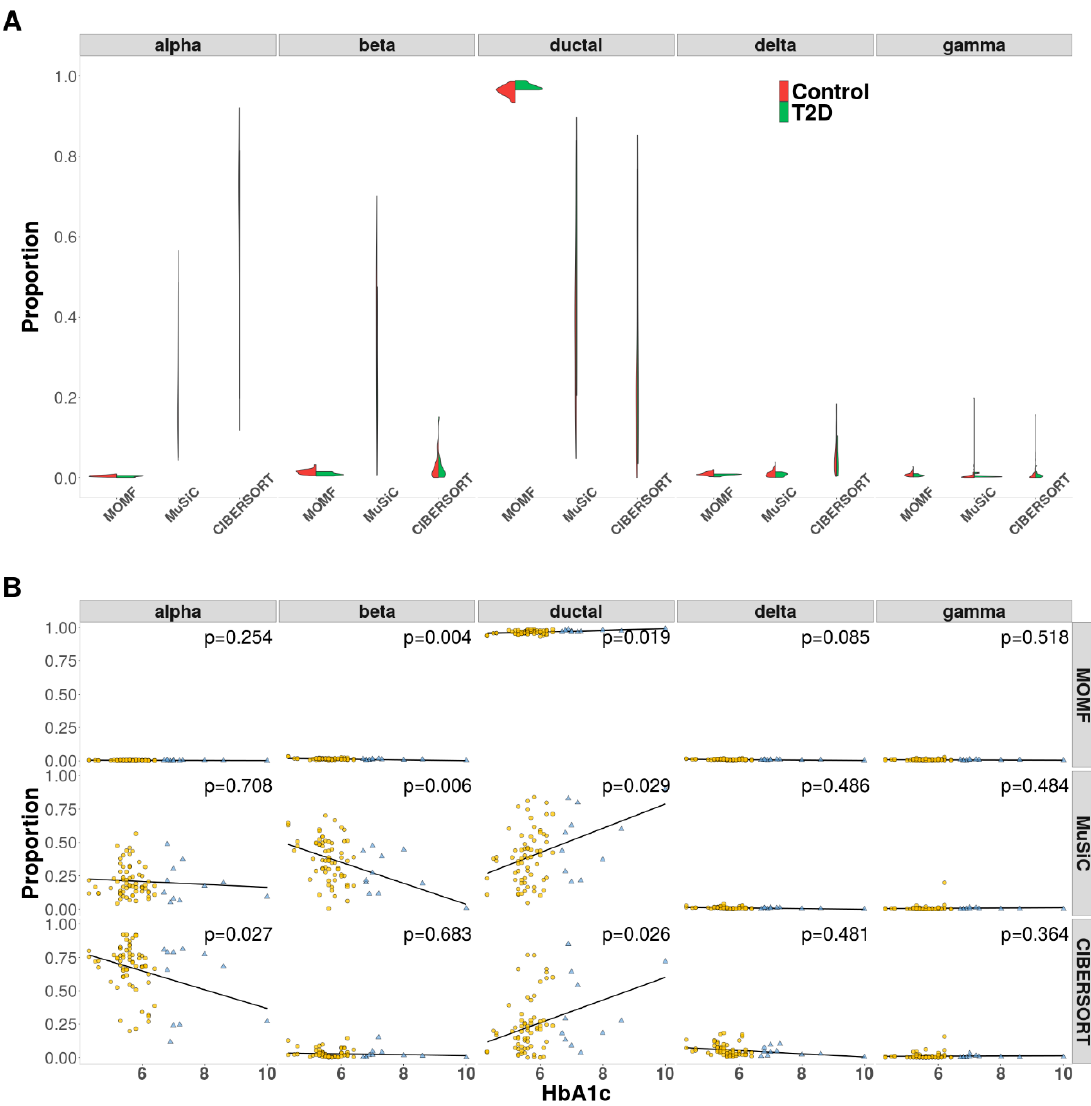
Figure 5. AnalyzingT2D bulk RNA-seq data with pancreatic scRNA-seq data. ( A ) The violin plot is to show the effect proportion of each cell type from three different methods. beta and ductal cells are enriched from MOMF, which means that the two cell types potentially contribute to the survival of CRC. ( B ) The scatter plots are used to show the results of the associations between Hb1Ac level and cell proportion as adjust the covariates. The estimated beta cell proportions by both MOMF and MuSiC are strongly associated with Hb1Ac ( p -value = 0.004 and 0.006).